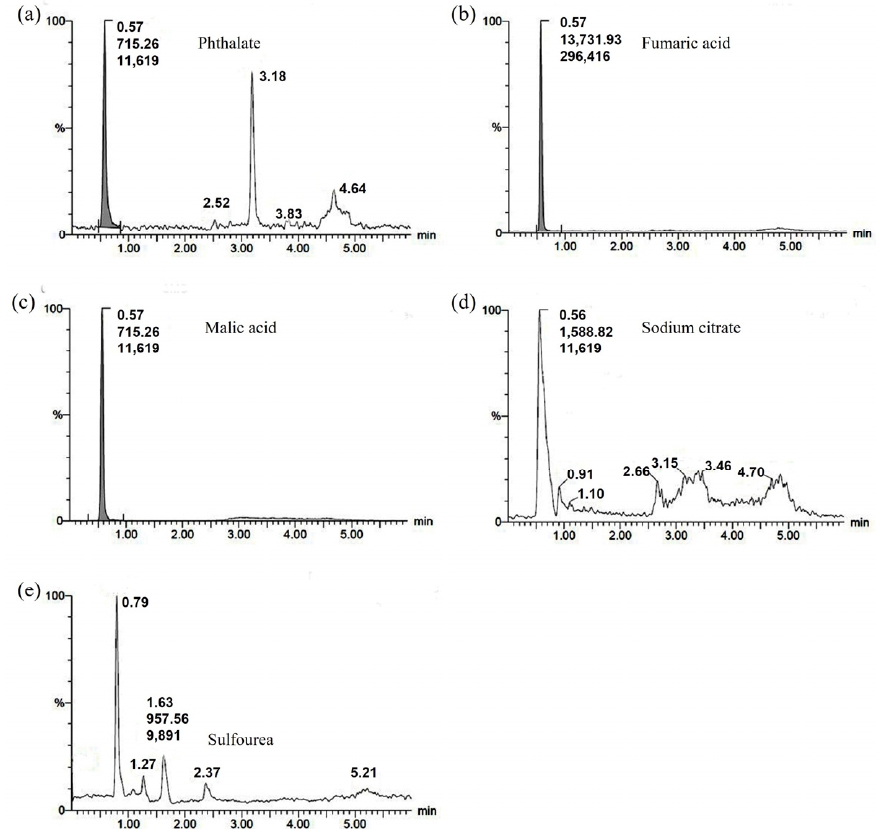
Figure 7. Chromatograms for water-soluble components in FAS: ( a ) Phthalate; ( b ) Fumaric acid; ( c ) Malic acid; ( d ) Sodium citrate; ( e ) Sulfourea.